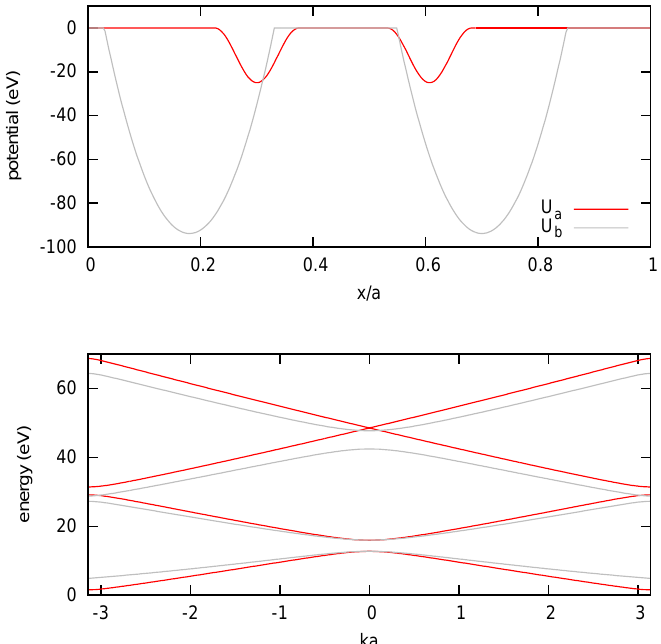
Figure 2. Top panel: The model potentials U ( a ) (red curve) and U ( b ) (grey curve) as a function of the coordinate x in a unit cell. The corresponding band schemes are shown in the bottom panel (where an additive scaling factor has been used in order to see more clearly that the band gaps are the same).